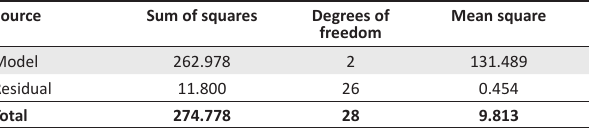
TABLE 3a: Regression model.